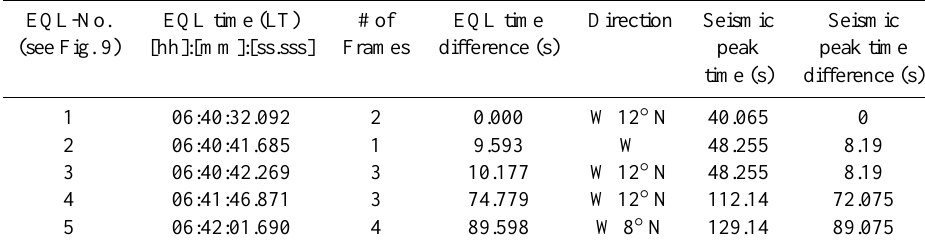
Table 3. Time of occurrence and direction of the